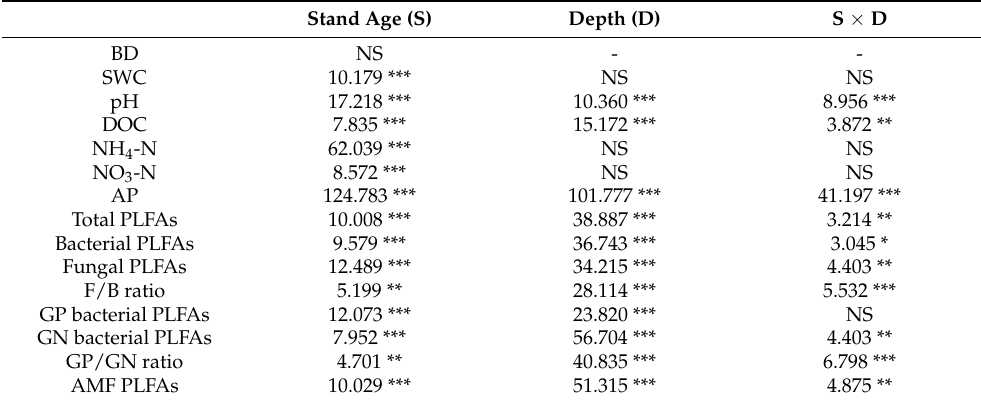
Table 2. Statistical significance of the effects of stand ages, soil depths and their interactions on soil properties and soil microbial communities (two-way ANOVA).